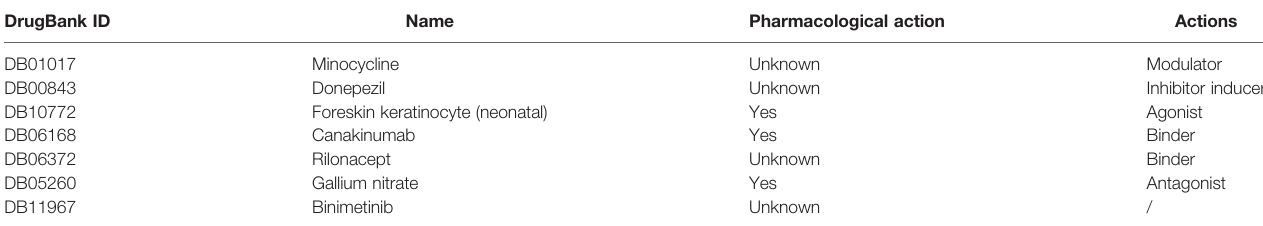
TABLE 4 | The drugs approved to interact IL1B.